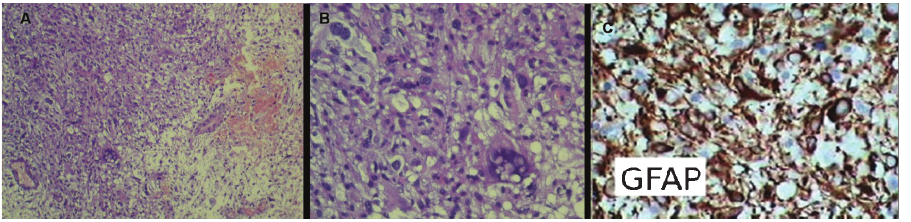
Figure 2 - A, B: Histological sections of cerebral tissue showing areas of elongated cells with pleomorphic and hyperchromatic nuclei that are associated with vascular neoformation and extensive hemorrhage and necrosis. C: Immunohistochemistry positive for GFAP.